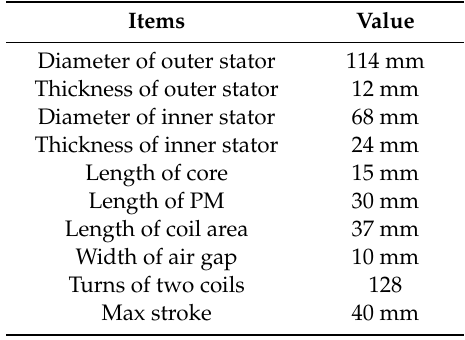
Table 1. Parameters of the designed linear